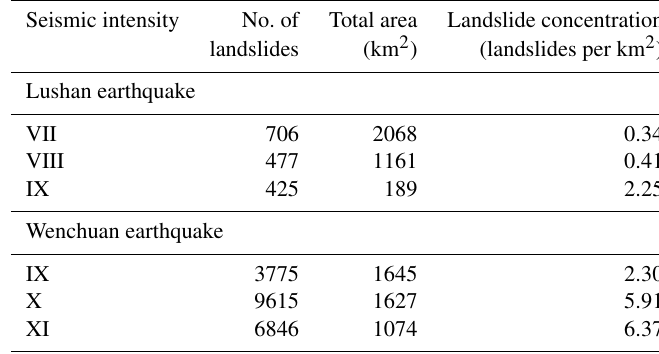
Table 3. Landslide concentrations in different seismic intensity zones.